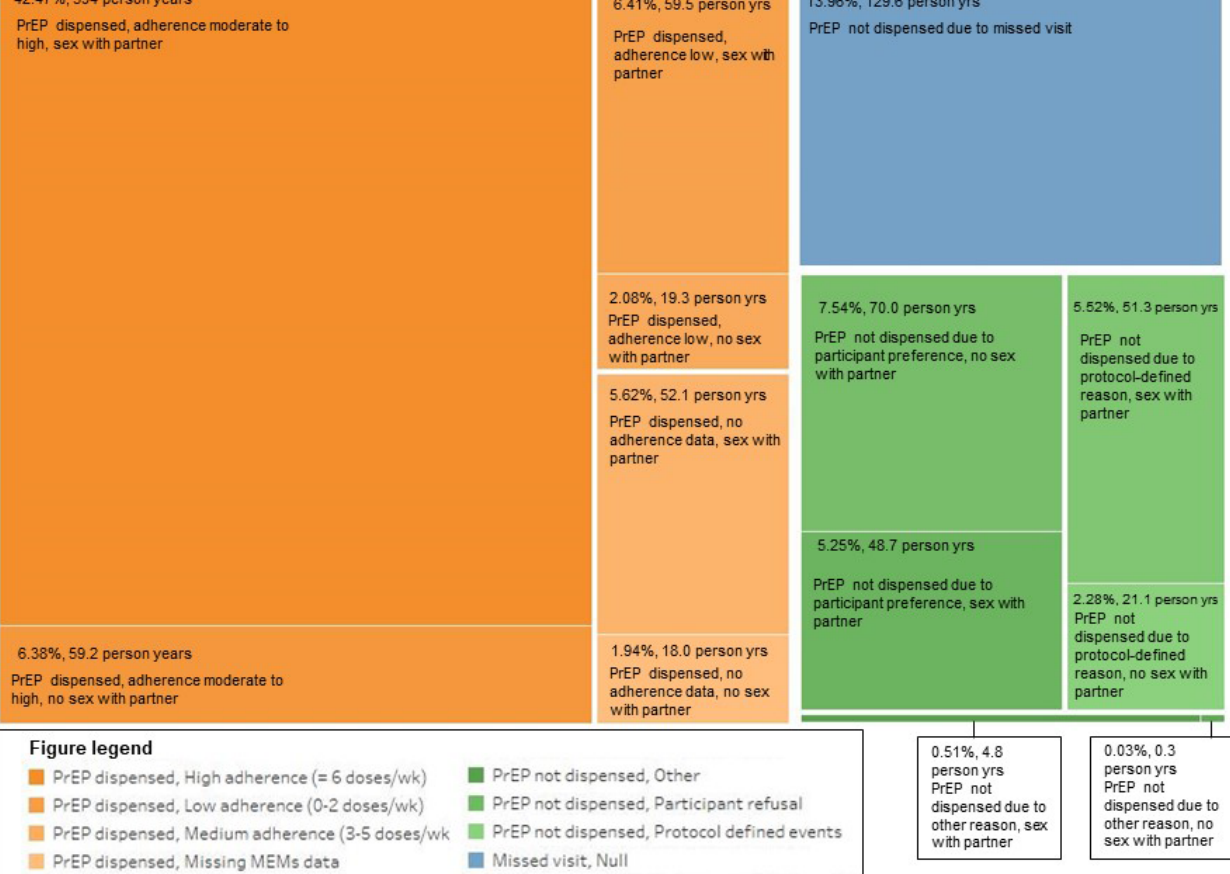
HIV incidence and intervention effectiveness . There were